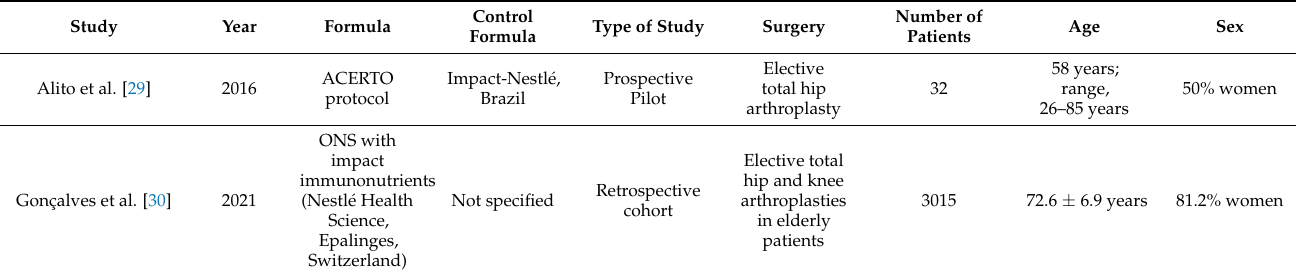
Table 6. Elective orthopedics studies.